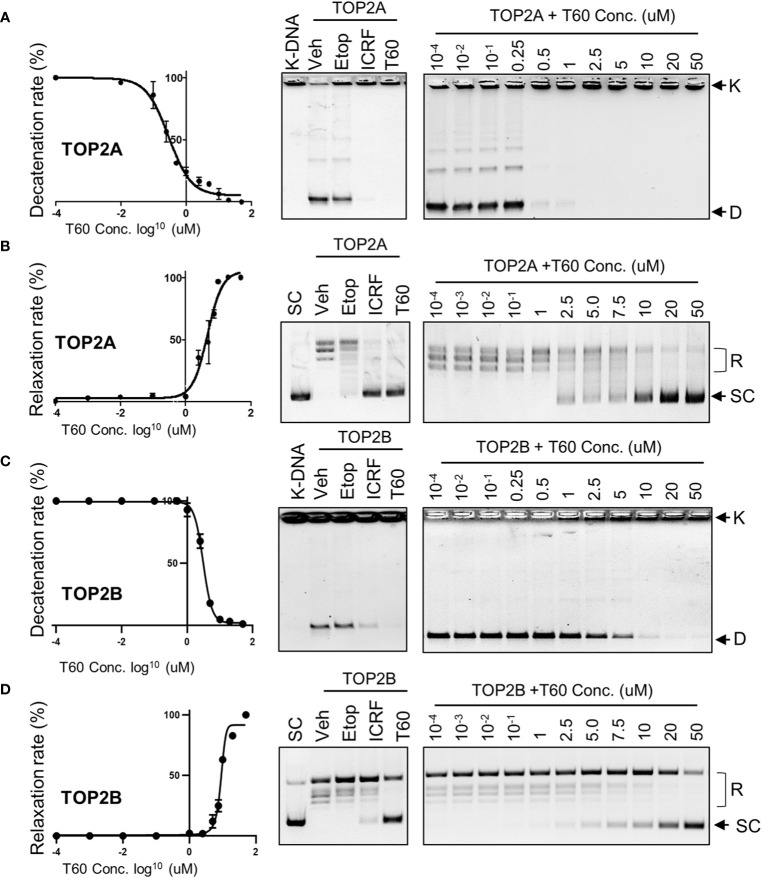
T60 is an inhibitor of TOP2A and TOP2B. K-DNA decatenation assays measured TOP2A (A) and TOP2B (C) activities that were inhibited by T60. The decatenation assays were repeated three times per concentration, and the densitometry of the D-DNA bands was used to establish an inhibition curve for IC50 calculation. Etoposide and ICRF193 were used as positive controls. Plasmid DNA relaxation assay measured TOP2A (B) and TOP2B (D) activities that were inhibited by T60. The relaxation assays were repeated three times per concentration and the densitometry of the SC bands was used to establish an inhibition curve for IC50 calculation. K, catenated kinetoplast DNA; D, decatenated K-DNA; SC, supercoiled forms of the plasmid; and R, relaxed forms of the plasmid.